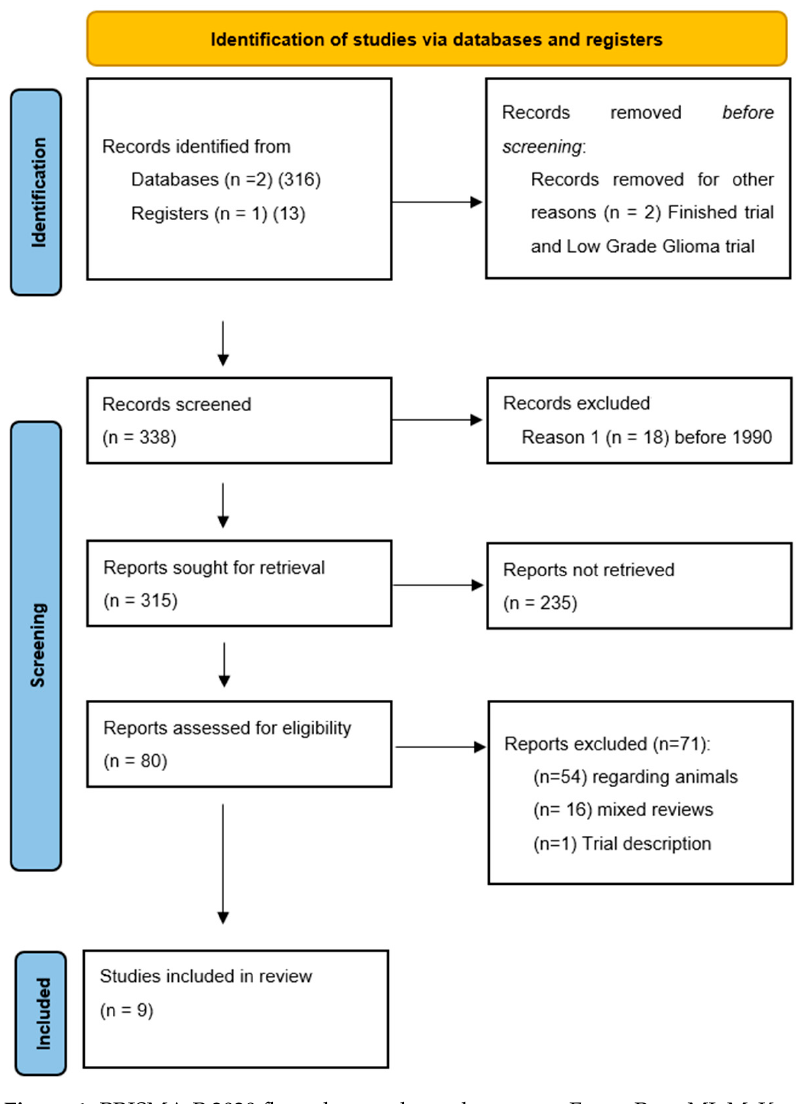
Figure 1. PRISMA-P 2020 flow-chart and search strategy. From: Page MJ, McKenzie JE, Bossuyt PM, Boutron I, Hoffmann TC, Mulrow CD, et al. The PRISMA 2020 statement: an updated guideline for reporting systematic reviews. BMJ 2021 , 372 , n71. doi:10.1136/bmj.n71. For more information, visit: